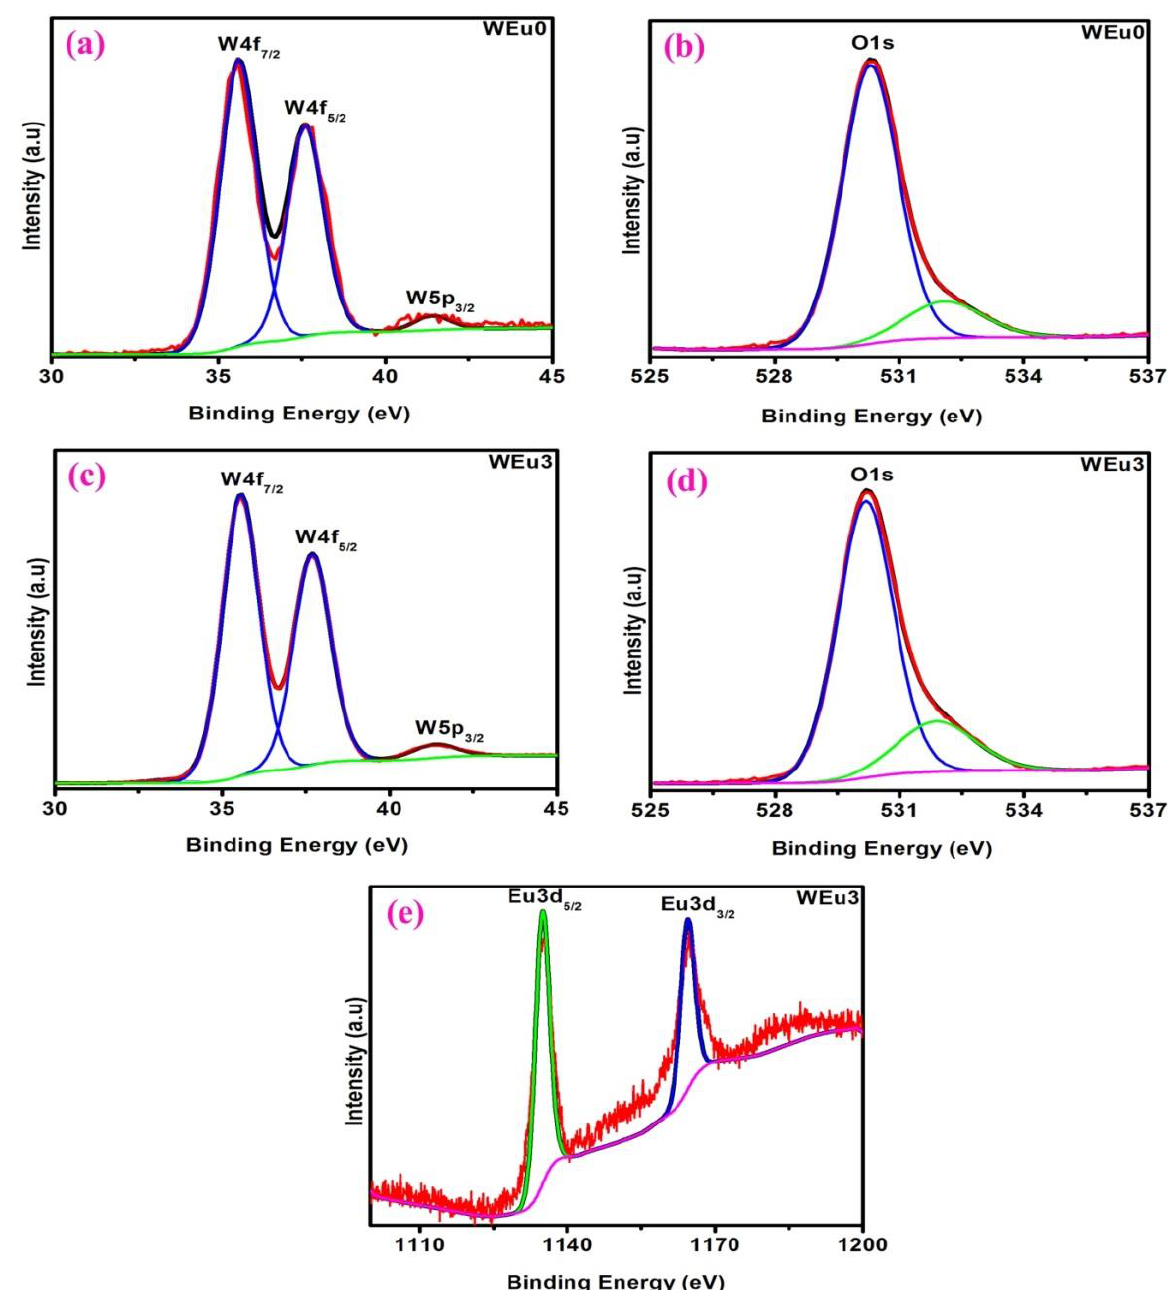
Figure 8. XPS survey spectra of ( a ) un-doped (WEu0) and ( b ) 3 wt% Eu 3+ -doped (WEu3) WO 3 films annealed at 600°C.